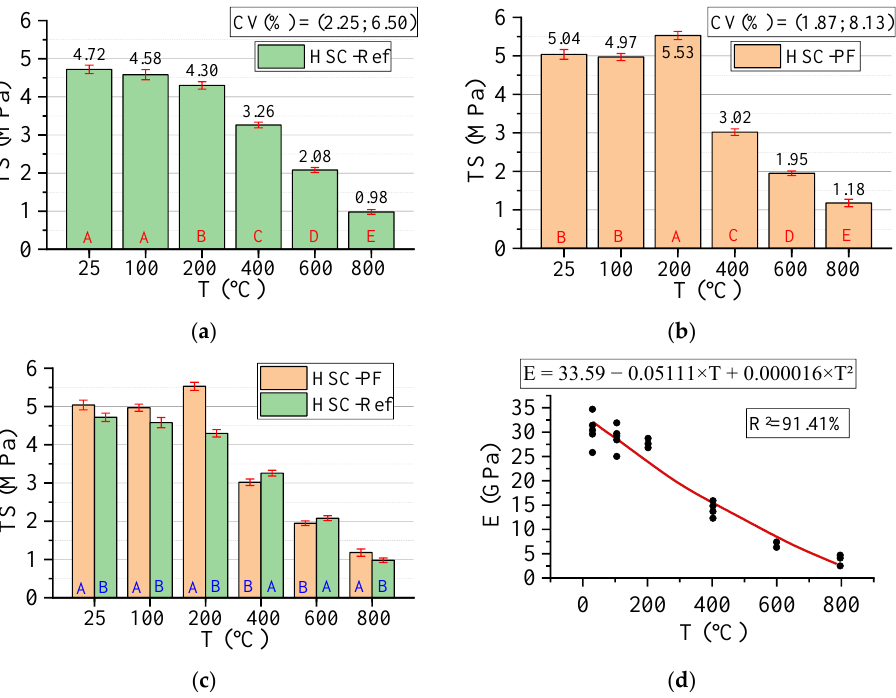
Figure 10. Summary of tensile strength (TS) results: ( a ) Tukey’s test for the samples without polypropylene fibers, ( b ) Tukey’s test for the samples with polypropylene fibers, ( c ) Tukey’s test for the samples without and with polypropylene fibers and ( d ) Quadratic regression model fit to the experimental data set considering only the effect of temperature as an independent factor. The uppercase letters A – E in figure mean equivalence between the sample results.